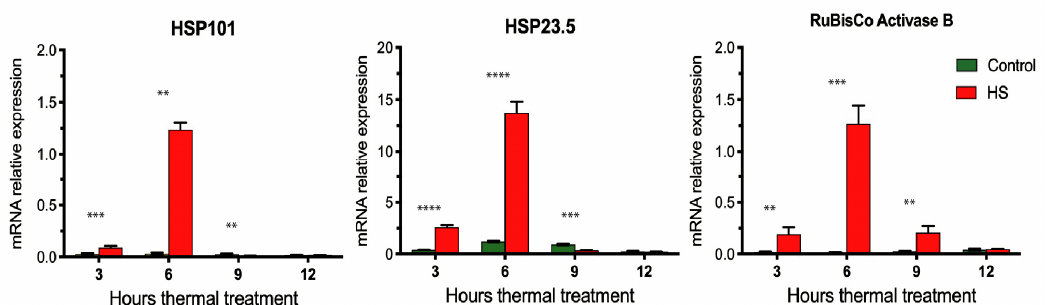
Figure 3. Temporal expression profiles of HS marker genes in durum wheat grains. Expression levels of three heat-stress gene markers at 3, 6, 9, and 12 h of starting thermal treatments by real-time qPCR. Heat-stress gene markers: heat shock protein (HSP) 101, HSP 23.5, and the Rubisco Activase B genes. Control: green color, and heat stress (HS): red color. Each column represents the mean of three biological replicates with ± standard deviations. Significant effects at Student’s t -test, p < 0.01 (**), p < 0.001 (***), p < 0.0001 (****).